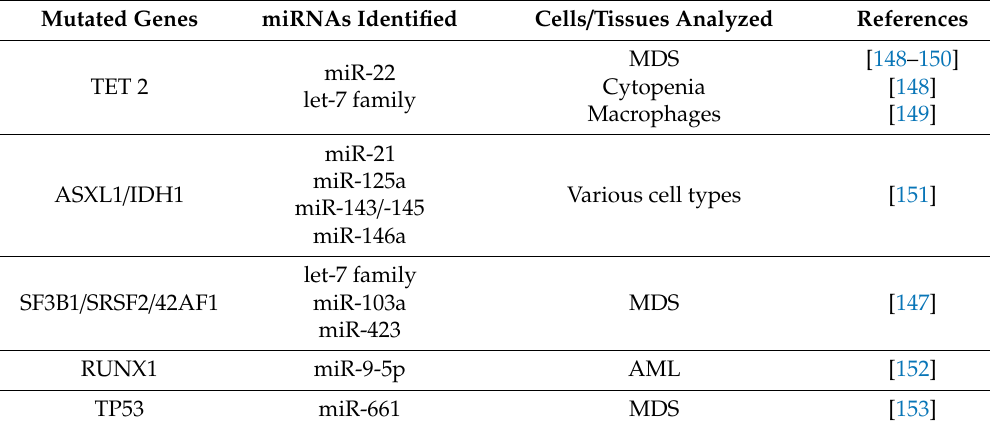
Table 3. miRNAs Targeting Genes Frequently Mutated in MDS and / or